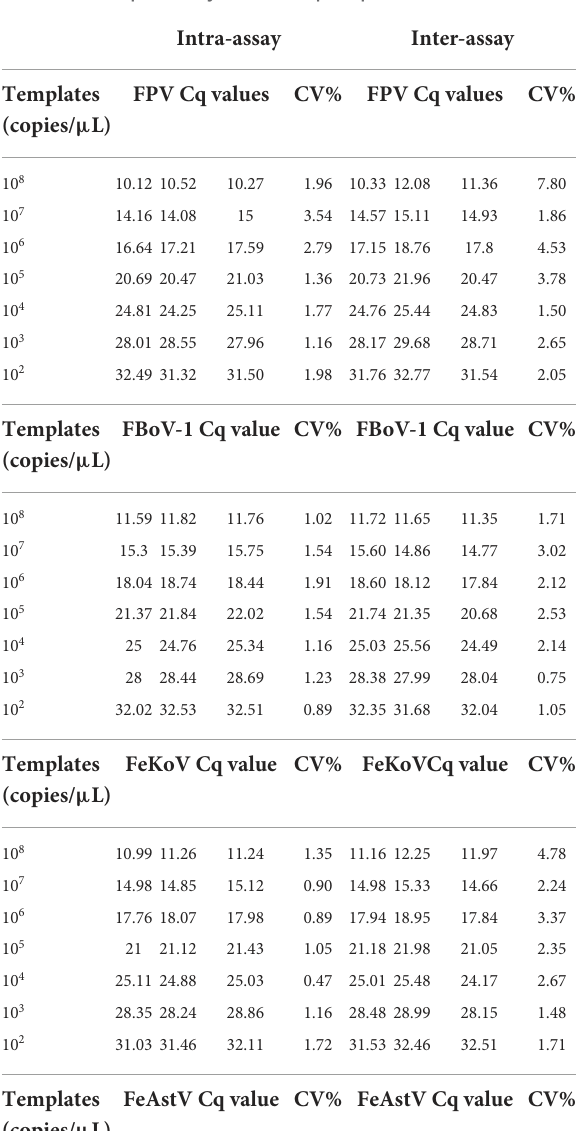
TABLE 3 The repeatability of the multiplex qPCR. TABLE 4 Sensitivity of the multiplex qPCR